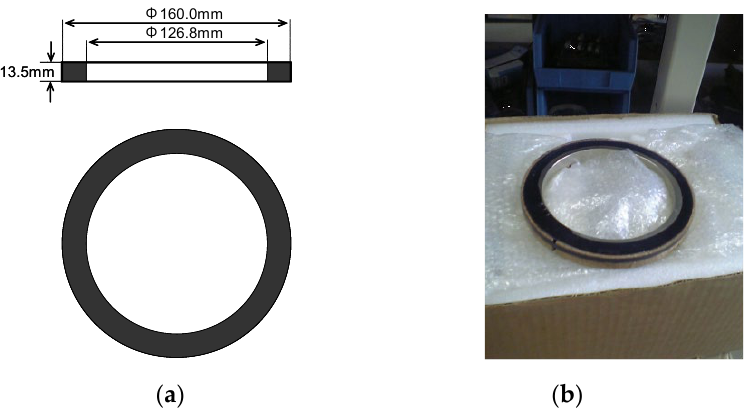
Figure 4. Permanent magnet of the rotor representing ( a ) the dimensions ( b ) photo.